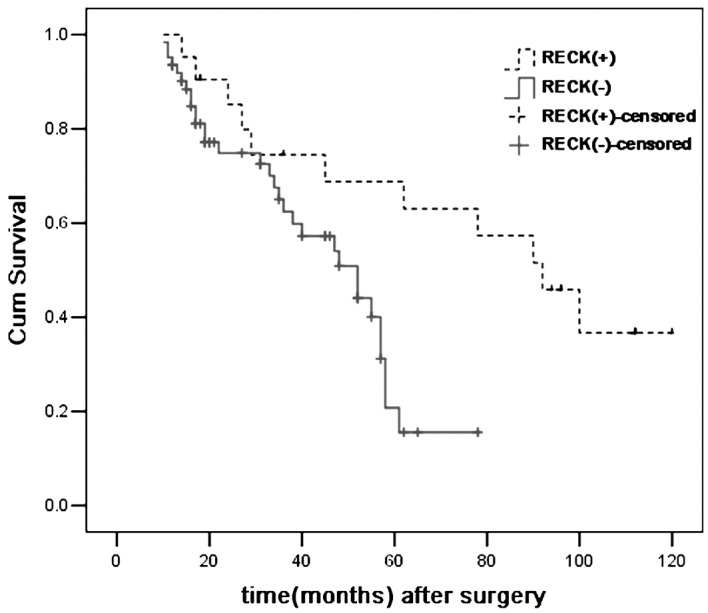
Kaplan-Meier survival curves for cumulative survival rate of SACC patients according to RECK expression (P=0.004). The solid line represents a negative staining result, and the dotted line represents a positive staining result. RECK, reversion-inducing cysteine-rich protein with Kazal motifs; MMP-2, matrix metalloproteinase-2.